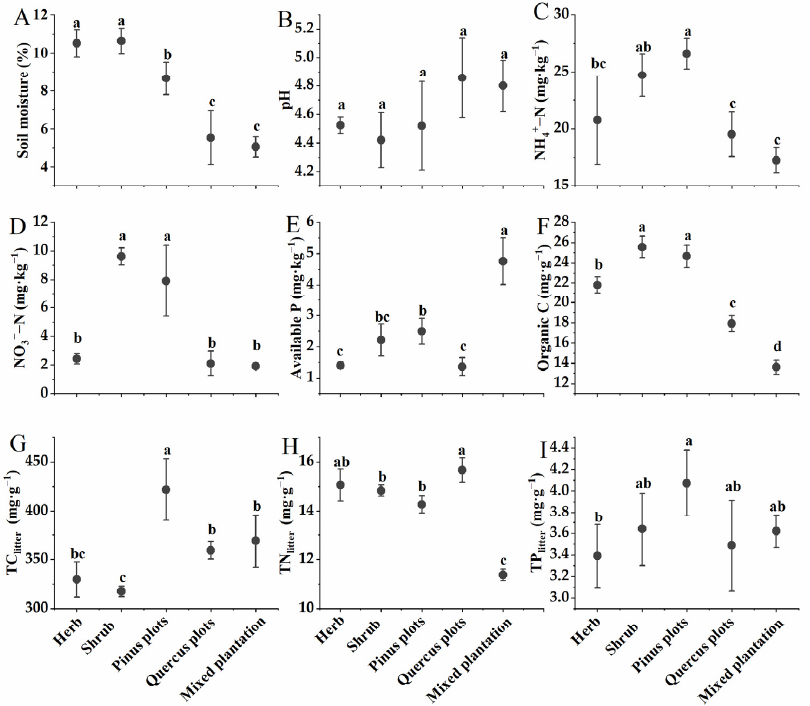
Figure 1. Descriptive statistics of soil and litter properties. TC litter : litter total carbon, TN litter : litter total nitrogen, TP litter : litter total phosphorus. ( A – F ) Soil physical and chemical indicators. ( G – I ) Litter nutrition indicators. Values are the means ± standard error. The different letters indicate significant differences between treatments according to the Tukey test; lowercase letters (such as a, b, c, d) indicate significant differences ( p < 0.05) among the five sampling plots.